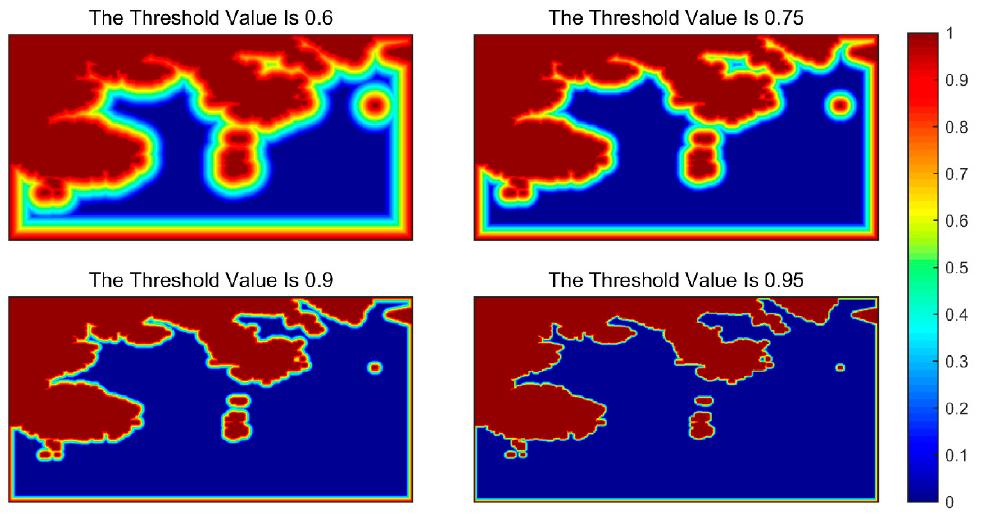
Figure 9. Environment model after different threshold processing.